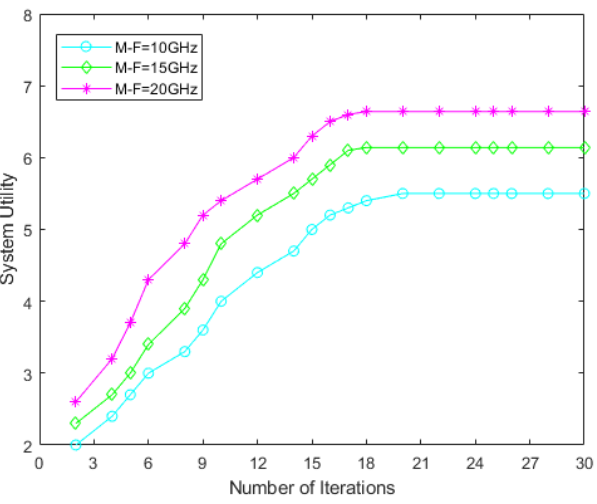
Figure 7. Impact of MEC resources.